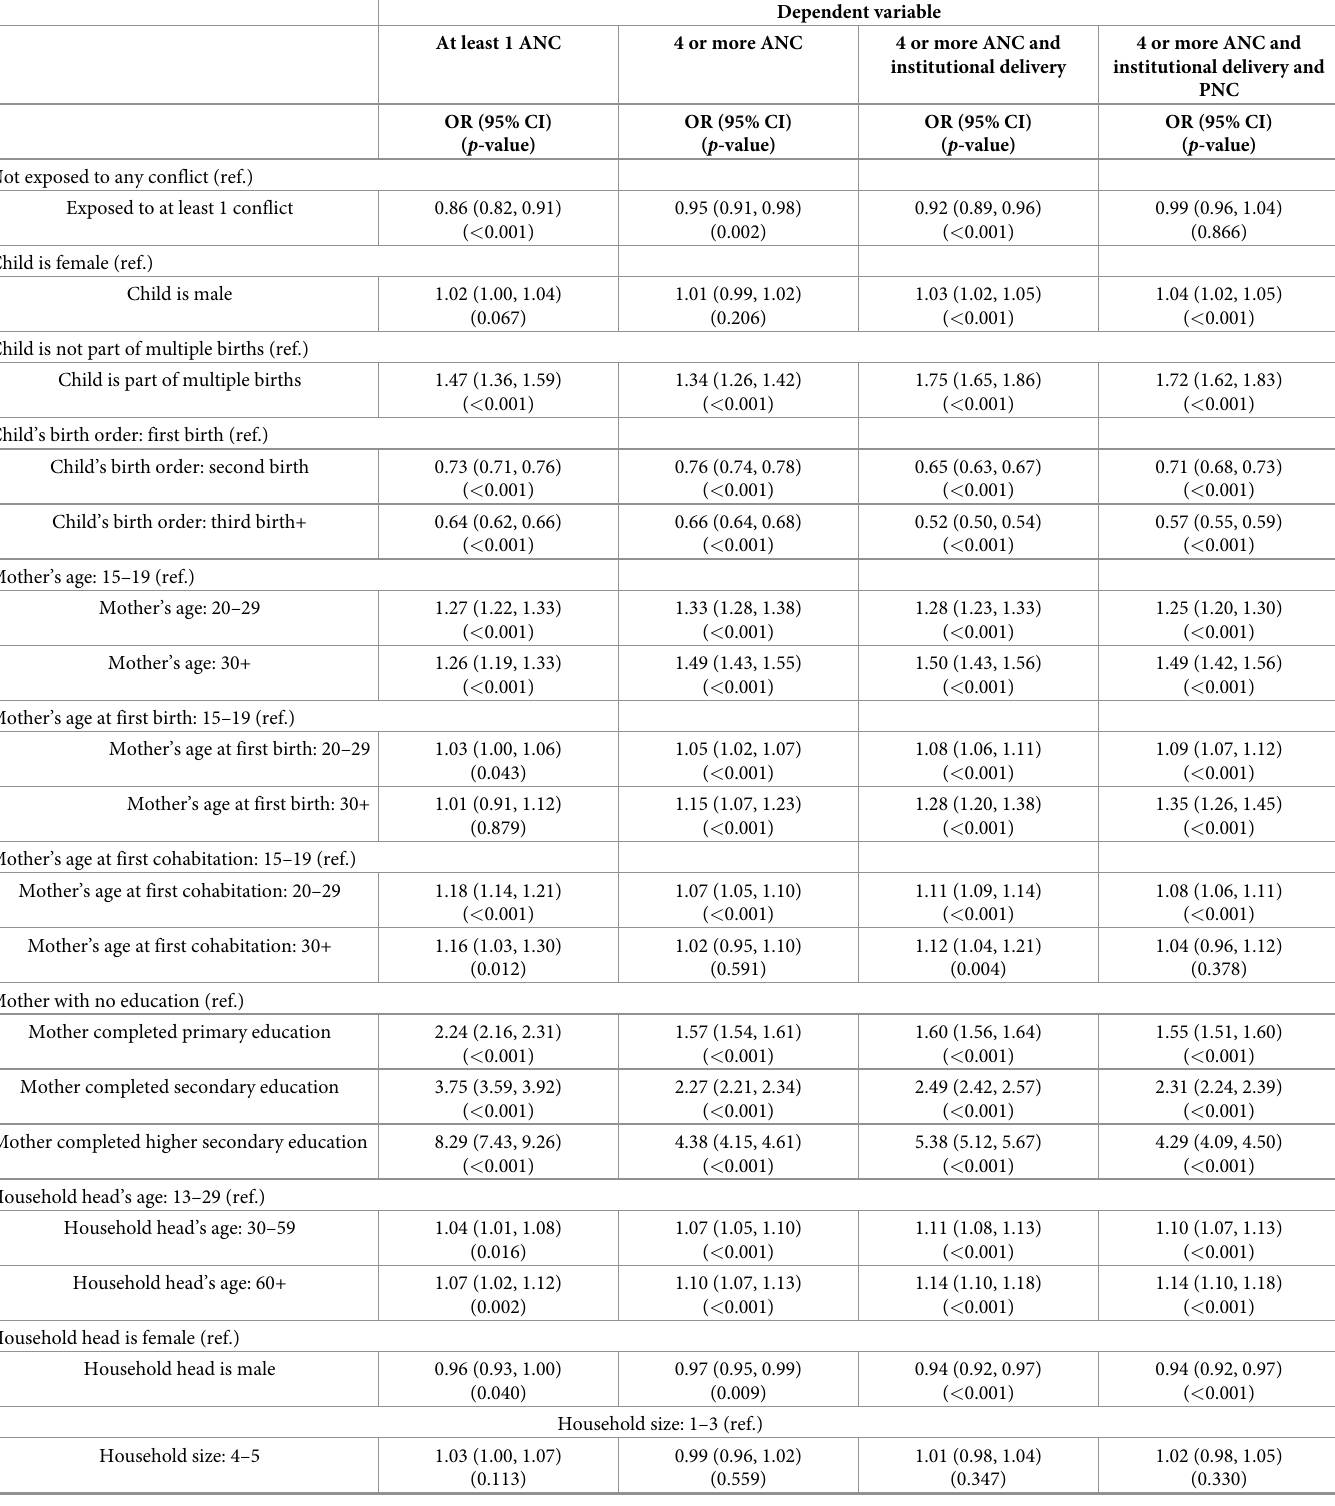
Table 3. Associations between exposure to conflict and